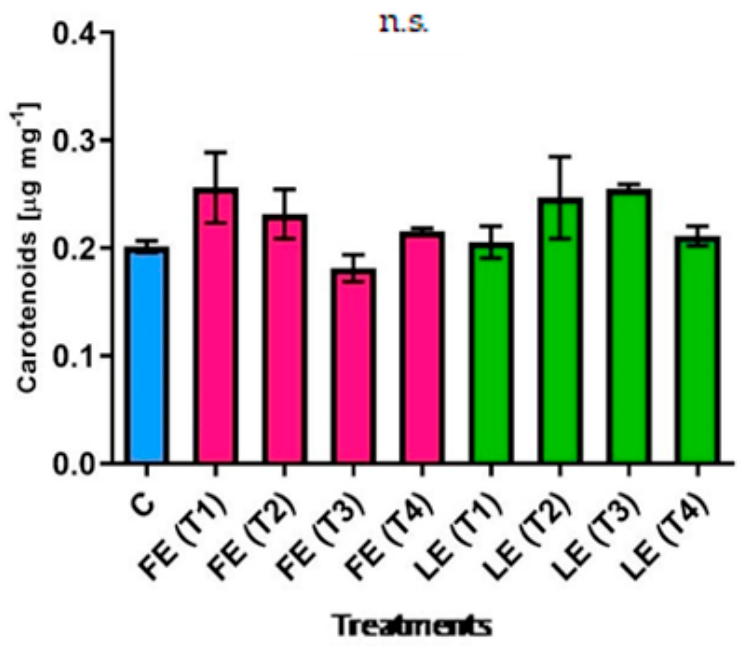
Figure 2. Carotenoids’ concentration in rocket leaves treated with water (control = C) and with borage extracts (flowers extract = FE or leaves extract = LE) obtained with different maceration times: 1 day (T1), 3 days (T2), 7 days (T3), and 14 days (T4). Values are means ± SE ( n = 3). Data were subjected to one-way ANOVA. “n.s.” means not significant.